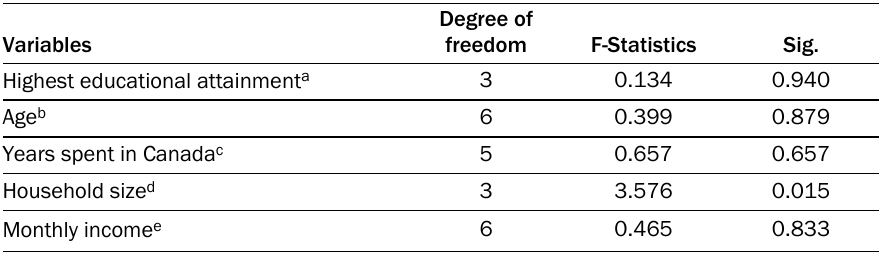
Table 10. Analysis of